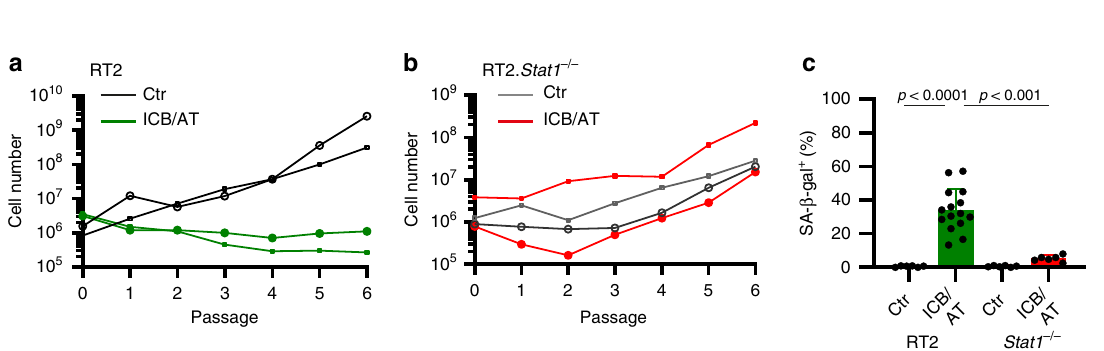
Fig. 6 Stat1 -dependent induction of the nuclear senescence markers p21 Cip1 , HP1 γ , H3K9me3, and of SA- β -gal in RT2-cancers by combined ICB/AT therapy. Representative fresh frozen cryostat sections of RT2-cancers from either RT2 or RT2. Stat1 − / − mice with established cancers were treated with either isotype control mAbs (Ctr), with adoptive transfer of TAA-speci fi c T H 1 cells (AT), with immune checkpoint inhibitors (ICB; anti-PD-L1 and anti- LAG-3), or with ICB/AT. a p21 Cip1 (red), Ki67 (blue), nuclei (green). b HP1 γ (red), nuclei (white). c H3K9me3 (red), nuclei (white). d Representative microscopic images of SA- β -gal activity at pH5.5 and percentage of SA- β -gal positive tumour cells in each tumour. The colour evaluation and calculation of the SA- β -gal + cells are described in Supplementary Fig. 2 and Methods. Scale bars 2 µ m ( a – c ), 1000 µ m ( d ). Histology was performed in one to three representative tumours from Fig. 4e.